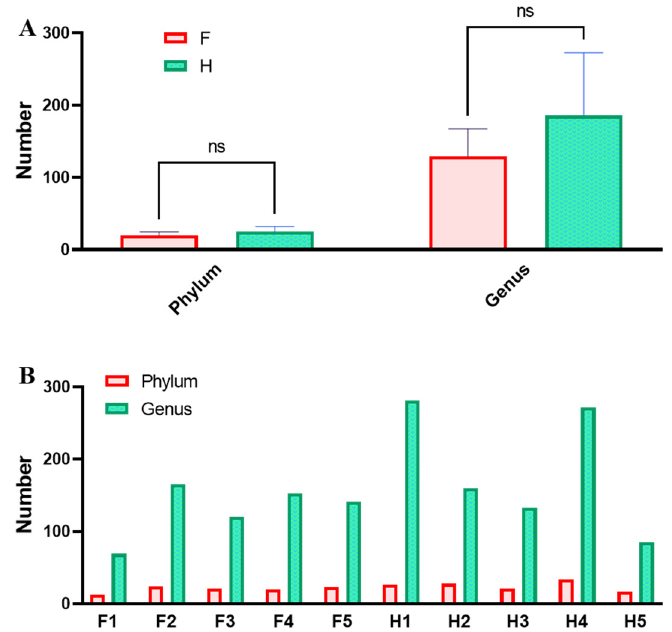
Figure 3. ( A ) Number of intergroup phyla and genera. ( B ) Number of phyla and genera in samples. F means factory production; H means household handmade.